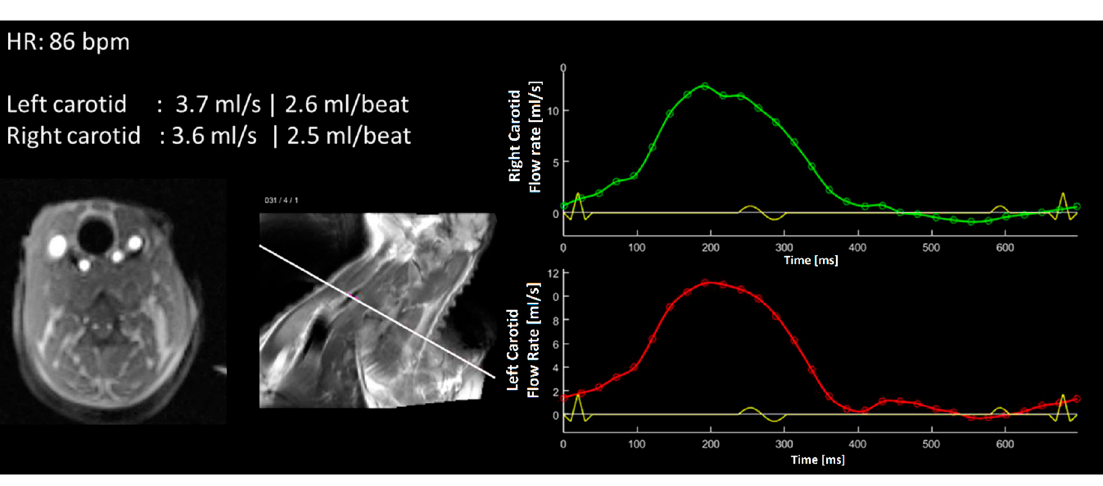
Figure 11. MRI scan of the neck section of one of the implanted sheep. Normal arterial flow and waveforms were recorded three days after implantation.